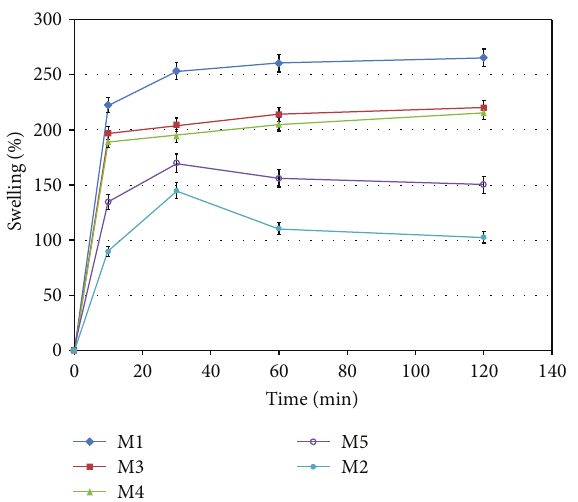
Figure 3: Swelling percentage of homogeneous MCCh (M1), Fb (M2), and composite: MCCh: Fb = 2 :1 (M3), 1:1 (M4), and 1: 2 (M5) membranes in phosphate buffer solution. pH 7.40 at 37 ∘ C from 24 h. The values are an average of three determinations.